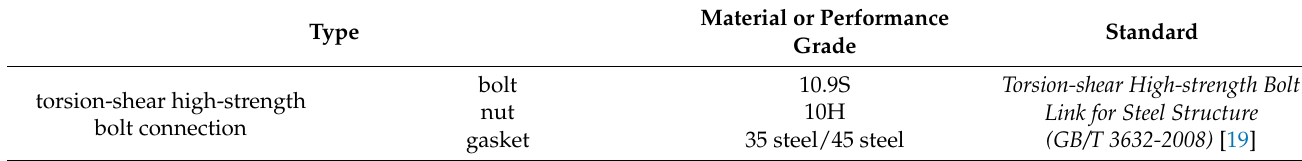
Table 1. High-strength bolt type, performance grade, and related specifications. Material or Performance Type Standard Grade bolt 10.9S Torsion-shear High-strength Bolt torsion-shear high-strength Link for Steel bolt connection